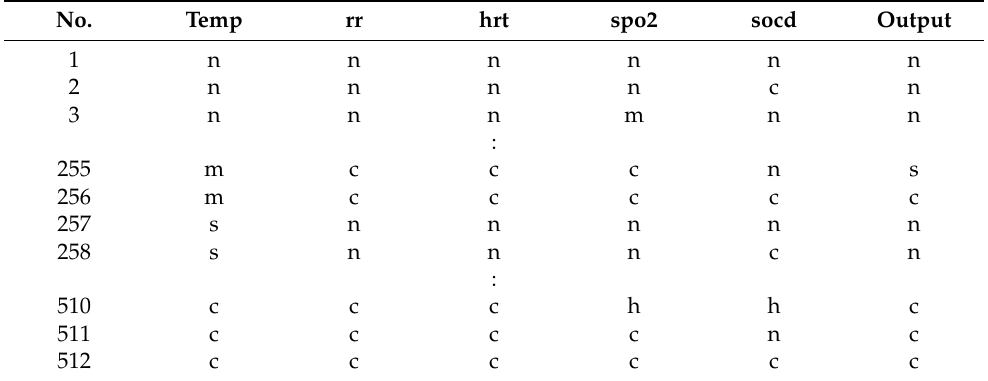
Table 7. Fuzzy rules induced for fuzzy set